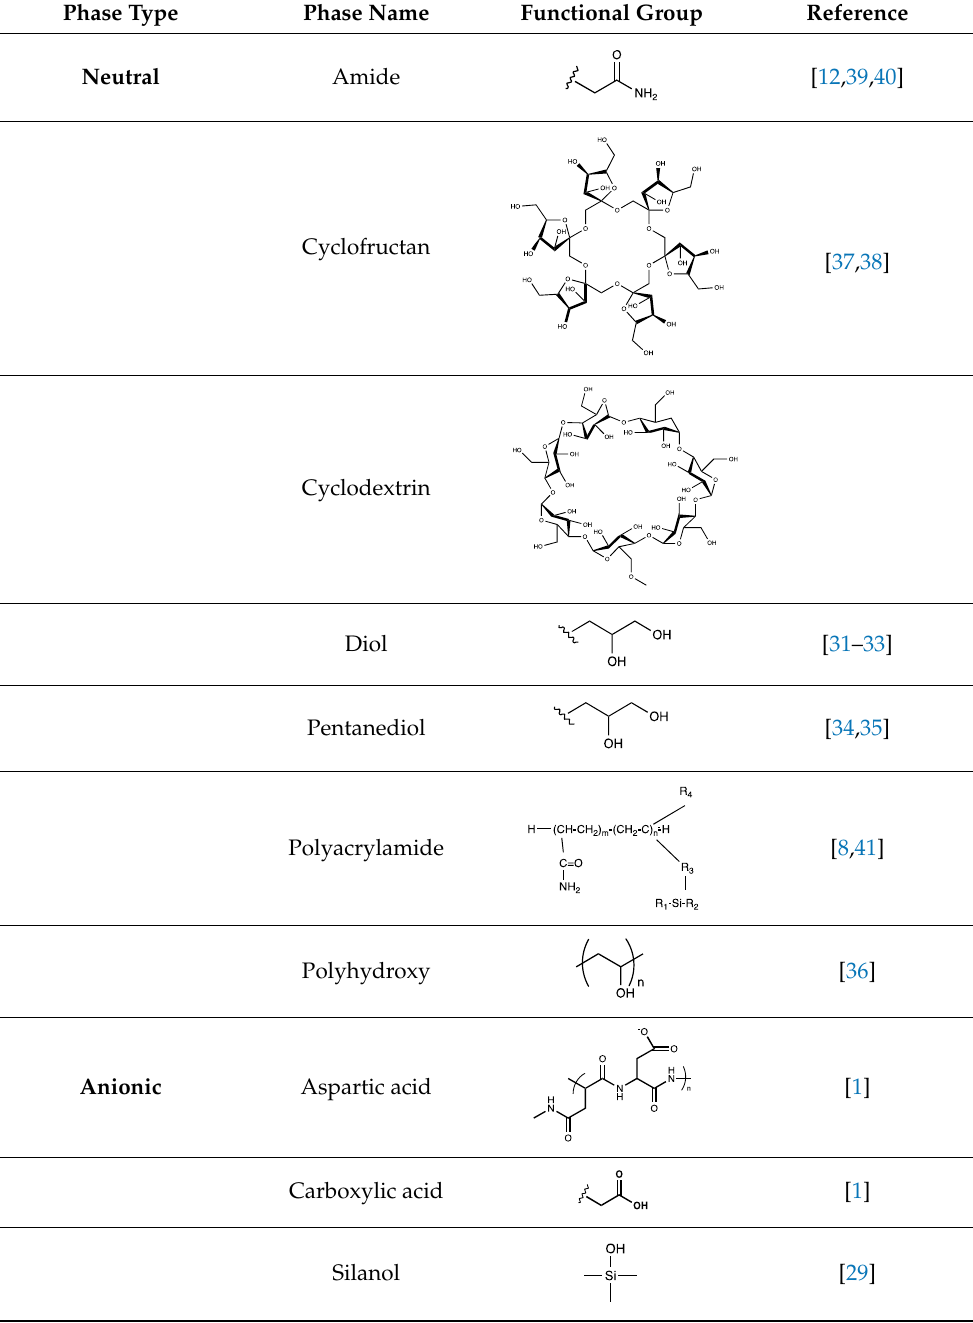
Table 1. Commercial stationary phases (in alphabetical order).